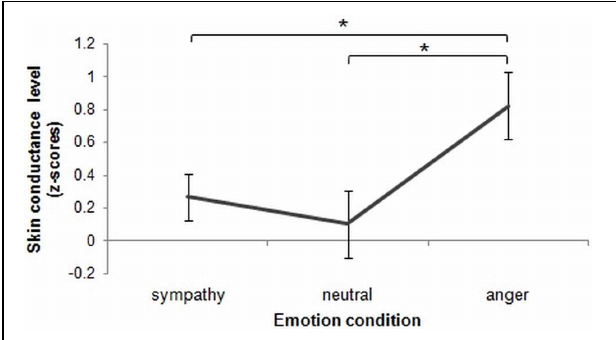
FIGURE 2 | Z-scores of mean skin conductance level (zSCL) as a function of emotion-induction. The mean zSCL during anger-induction was significantly higher than that of the neutral induction ( p = 0 . 005) and sympathy induction ( p = 0 . 029). Sympathy SCL was not significantly higher than that of the neutral condition ( p > 0 . 05). The asterisks highlight significant paired comparisons after Bonferroni correction ( p ≤ 0 . 017). Error bars represent ± 1 SEM.